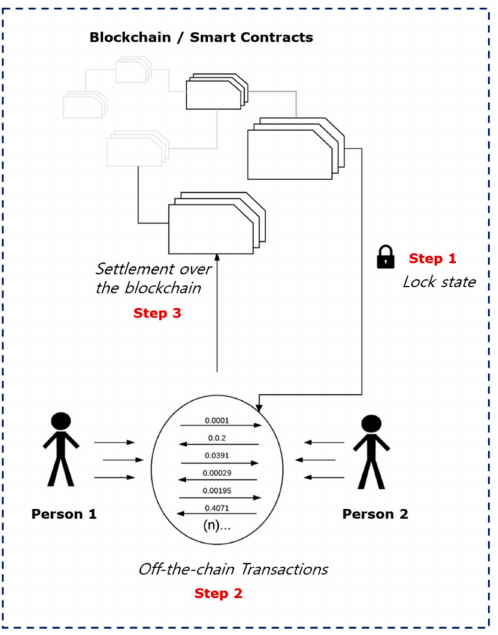
Figure 6. O ff -chain state channel